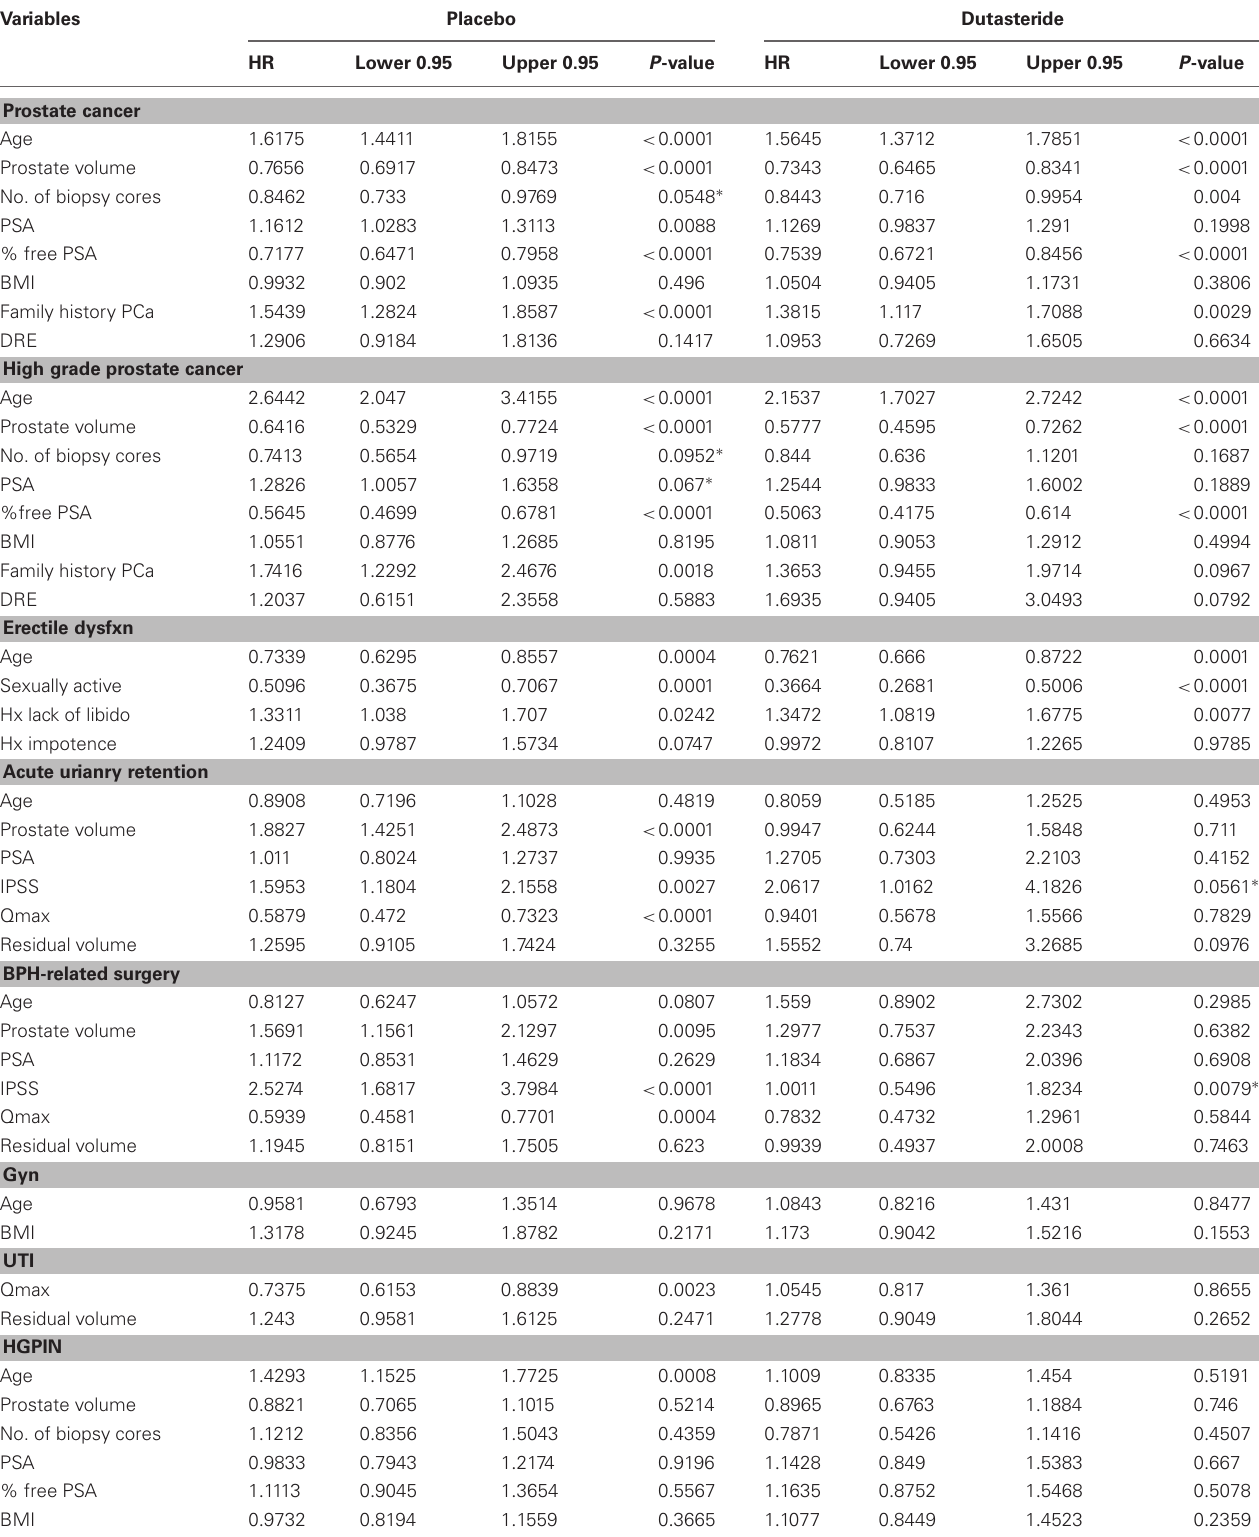
Table 3 | Hazard ratios and P -values from multivariate